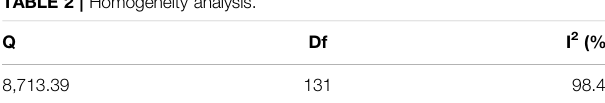
TABLE 2 | Homogeneity